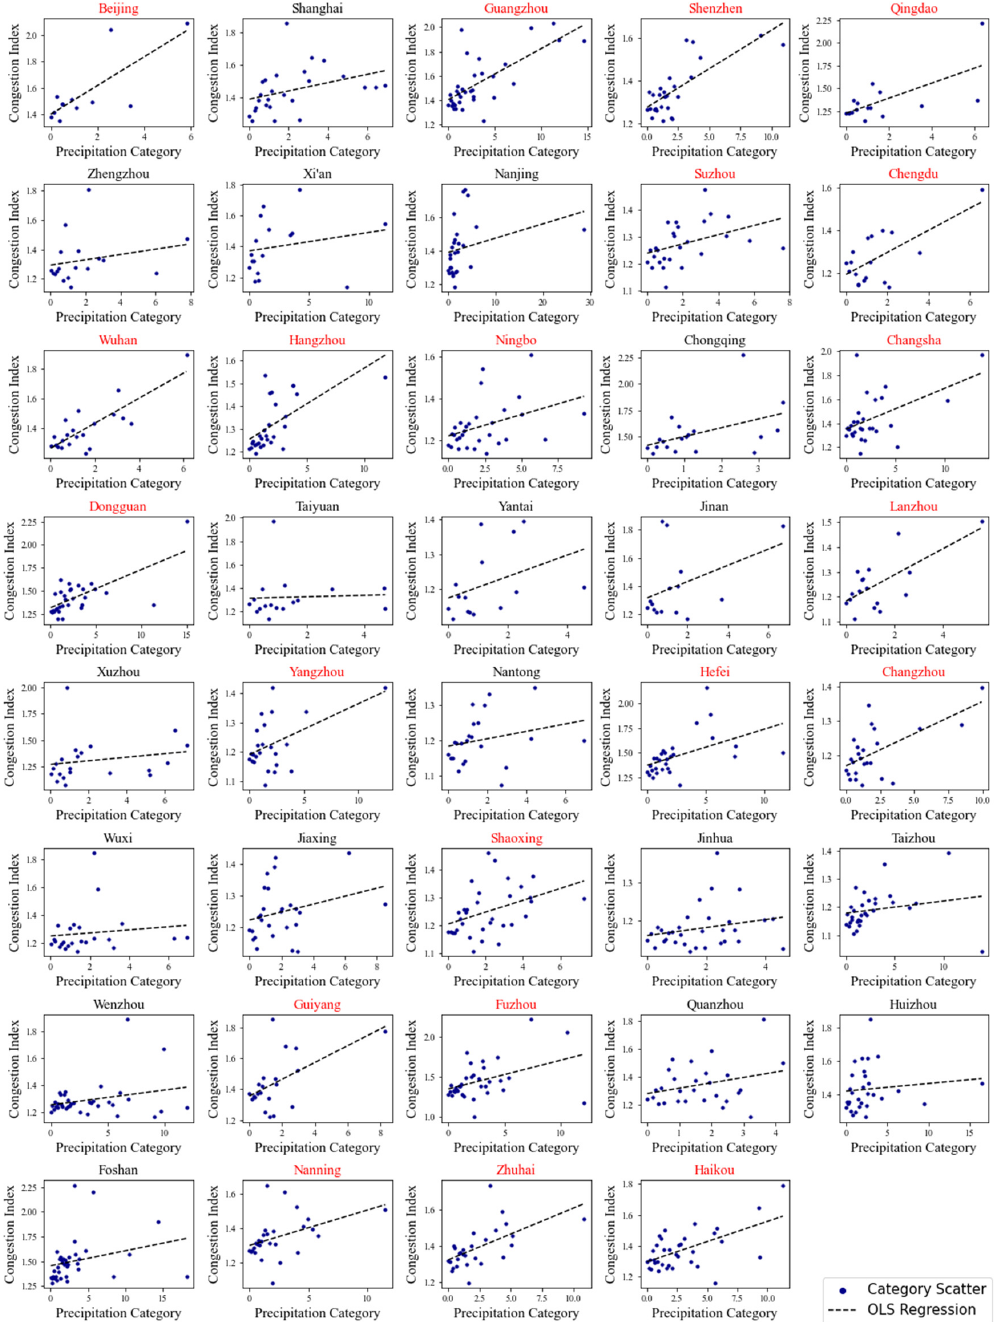
Figure 2. Statistical scatter plots and the ordinary least squares (OLS) regression analysis plots of the rainfall intensities and traffic congestion indexes.